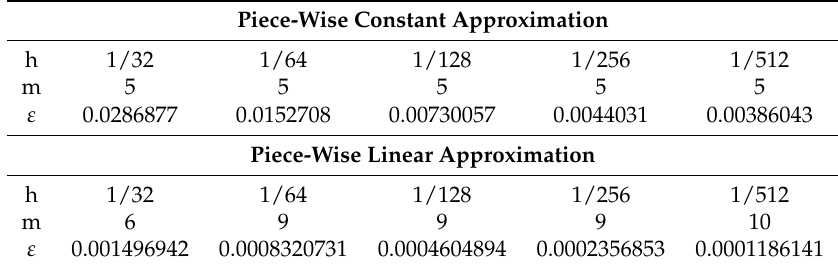
Table 3. Error analysis